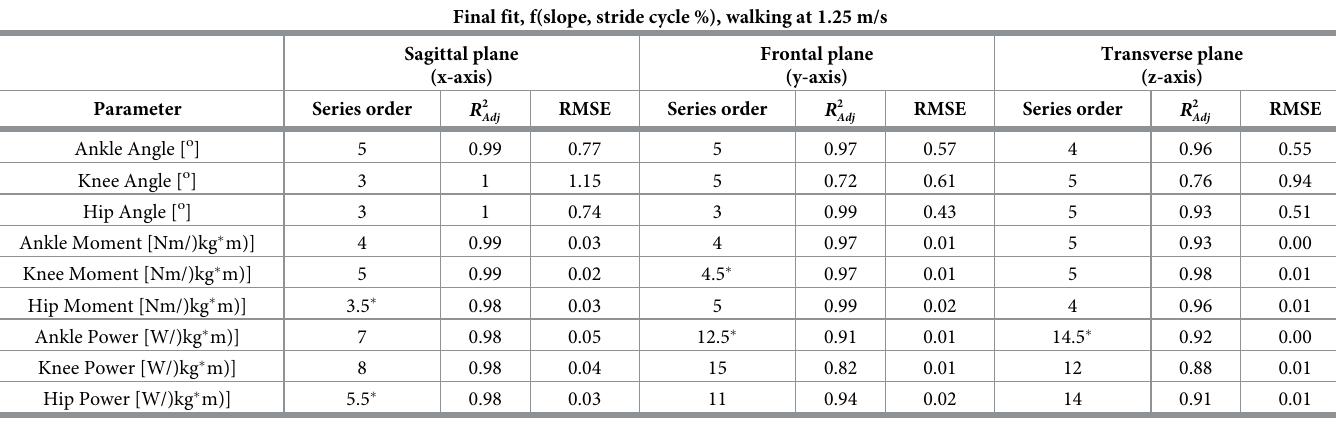
Table 4. Evaluation of the final fit (Stage 2) equations for each lower-limb joint variable, averaged on surface gradients, for walking at 1.25